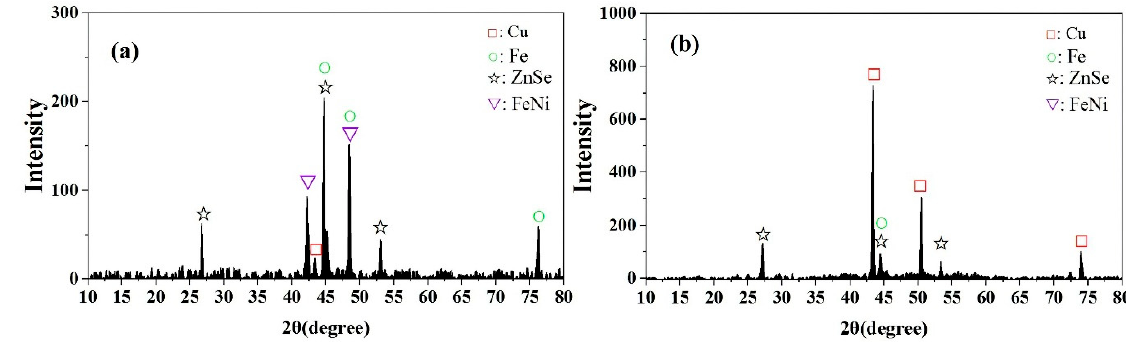
Figure 8. XRD patterns of high-gradient magnetic separation concentrates MA ( a ) and tailings NMA ( b ).